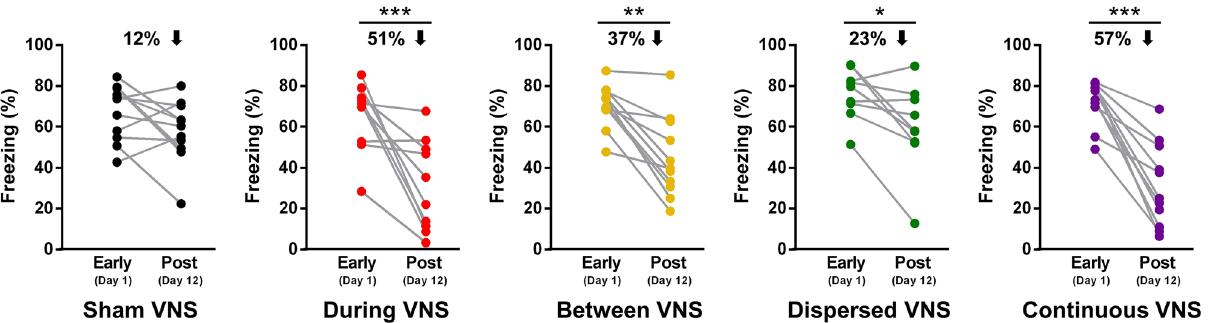
Figure 4. Percent of improvement from day 1 of extinction to retention test after extinction training. Sham VNS rats failed to show significant reduction in conditioned fear after extinction. All VNS groups showed significant reduction in conditioned fear, with the most robust effects seen in the groups that received During VNS or Continuous VNS. Data are represented by the mean ± SEM using the average of the five trials from each session, and analyzed by paired t-tests. *p < 0.05, **p < 0.005, ***p < 0.0005. Sham (n = 11), VNS during (n = 10), VNS between (n = 11), VNS dispersed (n = 9), VNS continuous (n =